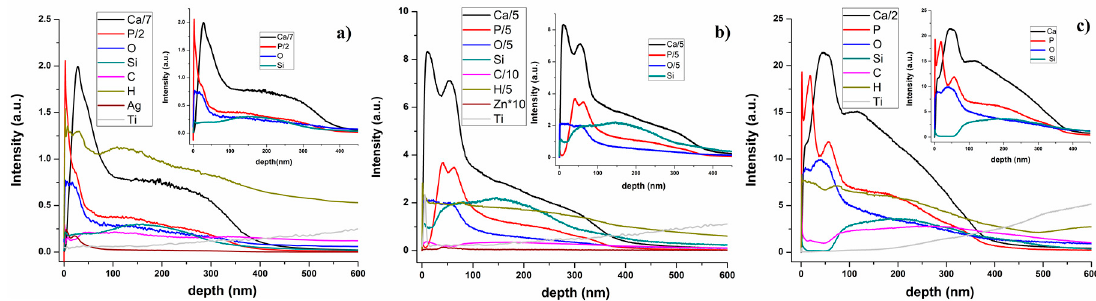
Figure 7. GDOES depth profiles of: ( a ) Ag:HAp-PDMS; ( b ) Zn:HAp-PDMS; ( c ) HAp-PDMS composite layers.